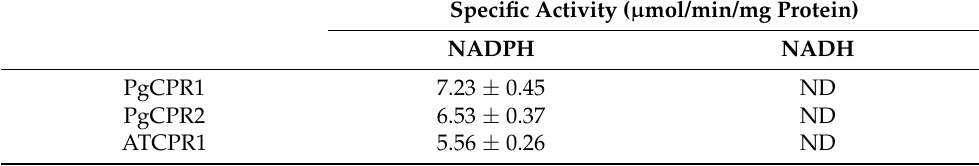
Table 2. Kinetic analysis of recombinant CPRs. All data represent the mean ± SDS calculated by nonlinear regression analysis using GraphPad Prism 7.0 software.